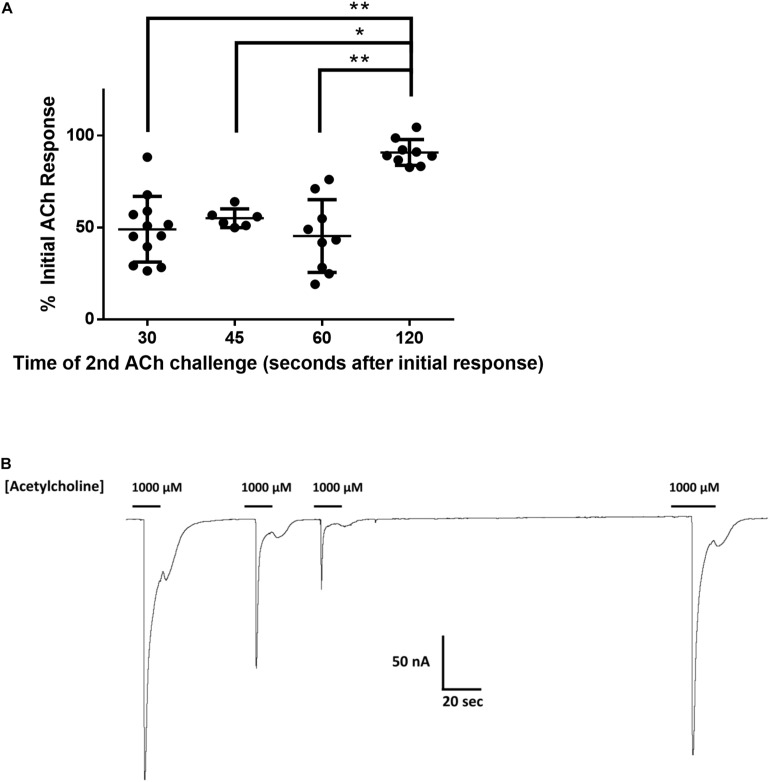
(A) The effect of time between subsequent applications of 1 mM acetylcholine on the magnitude of current elicited from Nam-ACR-16. Oocytes given 2 min recovery time from an initial acetylcholine exposure produced significantly larger currents than any other timepoint. Data at each time point were derived from experiments conducted on oocytes from at least two different frogs. n > 6, *p = 0.0004, **p < 0.0001. (B) Representative tracing of current responses from oocytes expressing Nam-ACR-16 induced by varying time between exposures to acetylcholine.